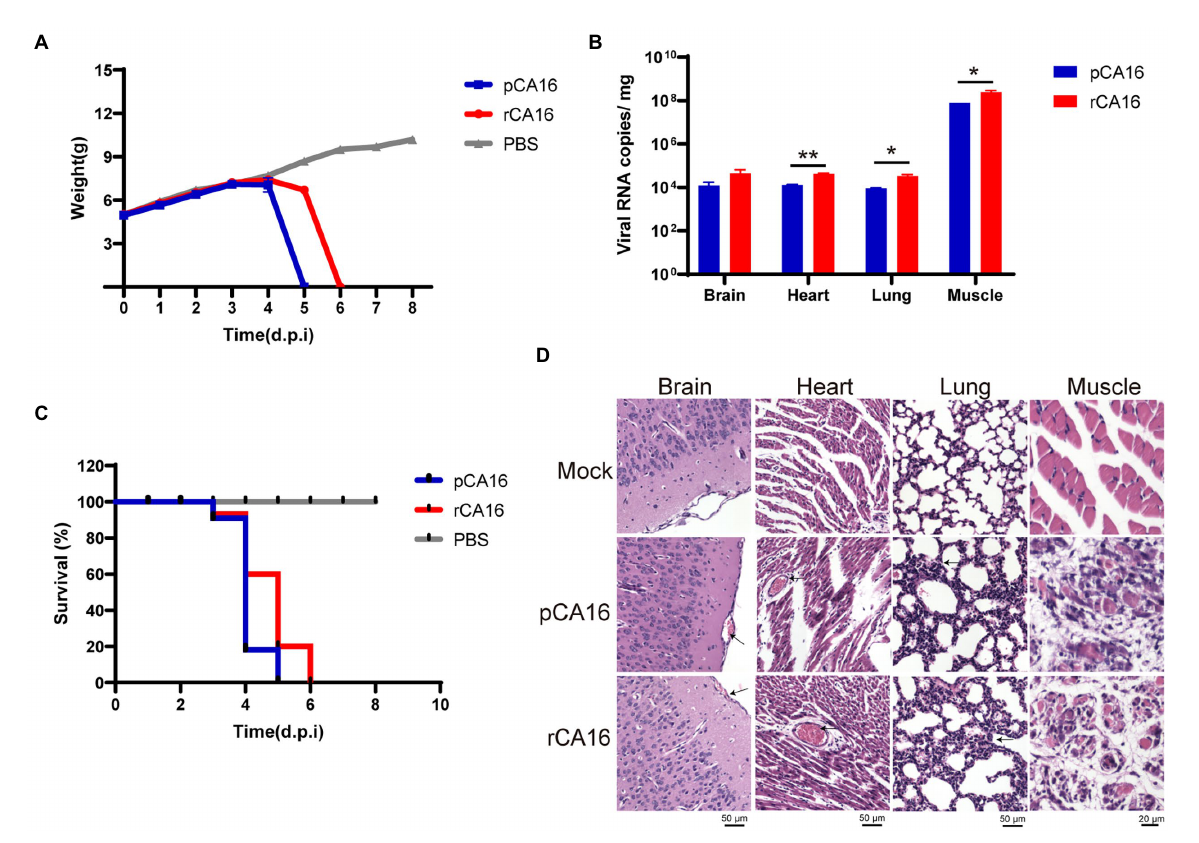
FIGURE 2 Virulence of the pCA16 and the rescued rCA16. One-week-old lactating mice were challenged intraperitoneally (i.p.) with 10 5 TCID 50 of pCA16 and rCA16. Mice in the control group were given an equal volume of PBS. (A) Changes in body weight in different groups. (B) The survival curve of the infected mice. (C) Viral RNA loads in the brain, heart, lungs and muscles 4 days after infection. (D) The pCA16 and rCA16 infection caused leptomeningeal hemorrhage, thickened alveolar walls, and ruptured thigh and myocardial muscles. Statistical differences were determined using t-test (* P < 0.05; ** P < 0.01; *** P < 0.001; **** P <